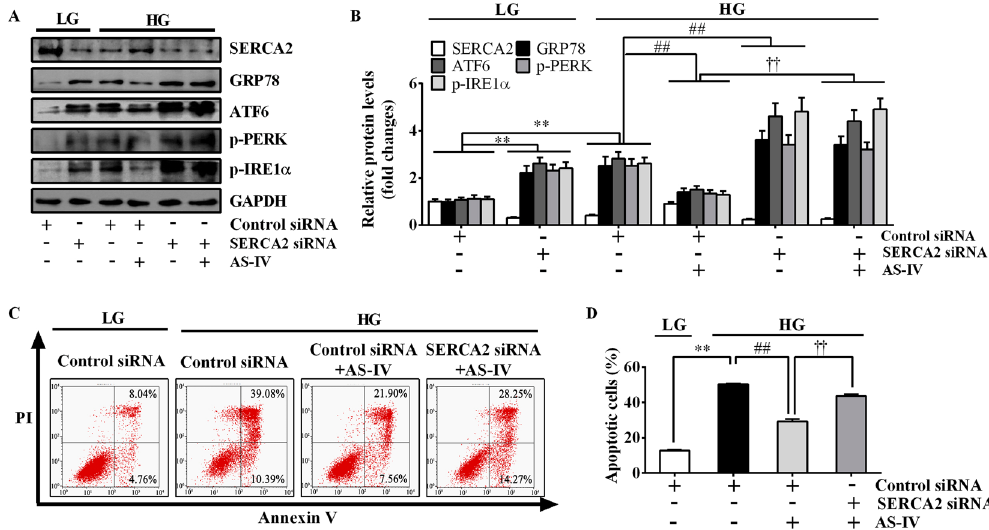
Figure 7. SERCA2 mediated the inhibitory effect of AS-IV on HG-triggered ER stress. Podocytes were transfected with control siRNA or specific SERCA2 siRNA for 6 h, and then treated with HG in the presence or absence of 80 μ M AS-IV for 24 h (ER stress detection) or 72 h (apoptosis). ( A ) Representative immunoblots of SERCA2 and ER stress-associated proteins under different conditions as indicated. ( B ) Densitometric quantification of SERCA2 and ER stress-associated proteins as shown in panel A. ( C ) Representative flow cytometry results for podocytes cultured under different conditions as indicated. ( D ) Quantitative analysis of apoptotic cells determined by flow cytometry as shown in panel C. Data are expressed as mean ± SEM. n = 3. ** P < 0.01 compared to LG plus control siRNA group. ## P < 0.01 compared to HG plus control siRNA group. †† P < 0.01 compared to HG plus control siRNA and AS-IV group. The original blots for panel A were presented in Supplementary Figure S8. One-way ANOVA and Newman-Keuls multiple comparisons test ( B , D ). LG, low glucose; HG, high